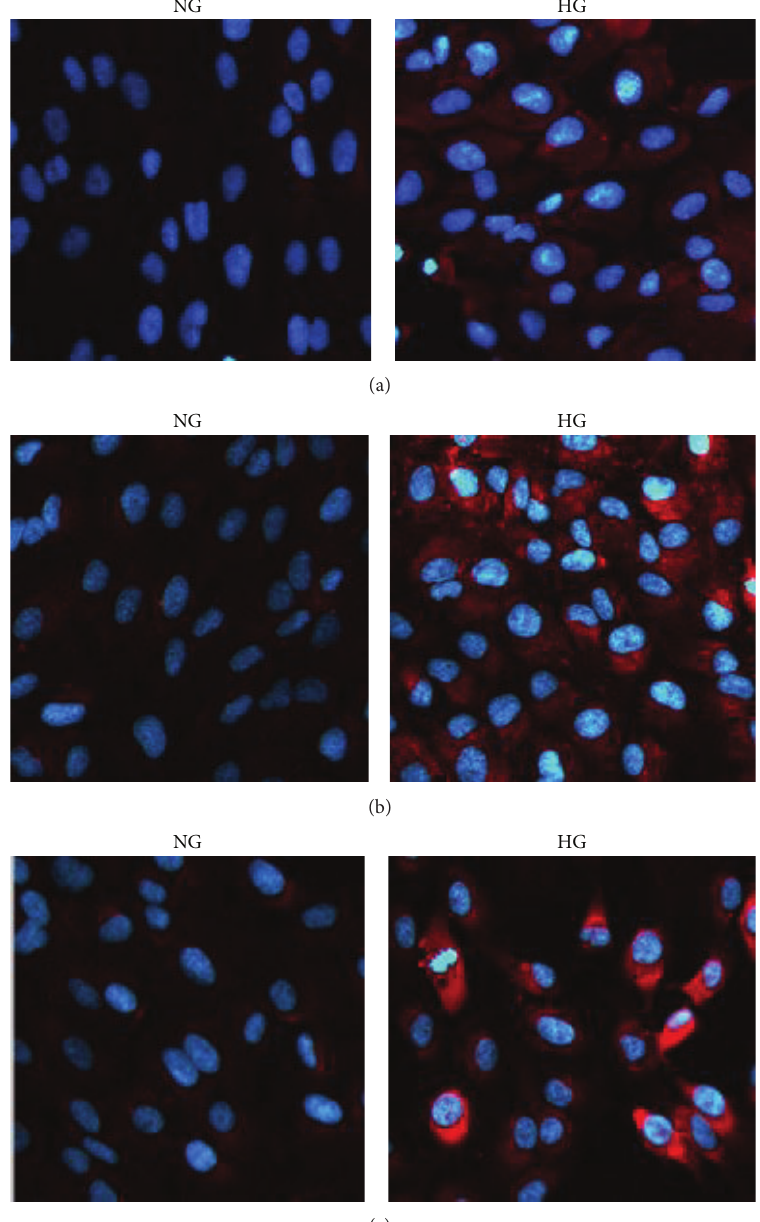
Figure 3: Immunofluorescence evaluation of fibronectin, collagen IV, and laminin in RPE cells. The expression of fibronectin, collagen IV, and laminin was evaluated after incubation with 24 h in RPE cells under high glucose conditions. The RPE cells showed more intense staining under high glucose conditions compared with NG. (a) fibronectin; (b) collagen IV; (c) laminin. DAPI: